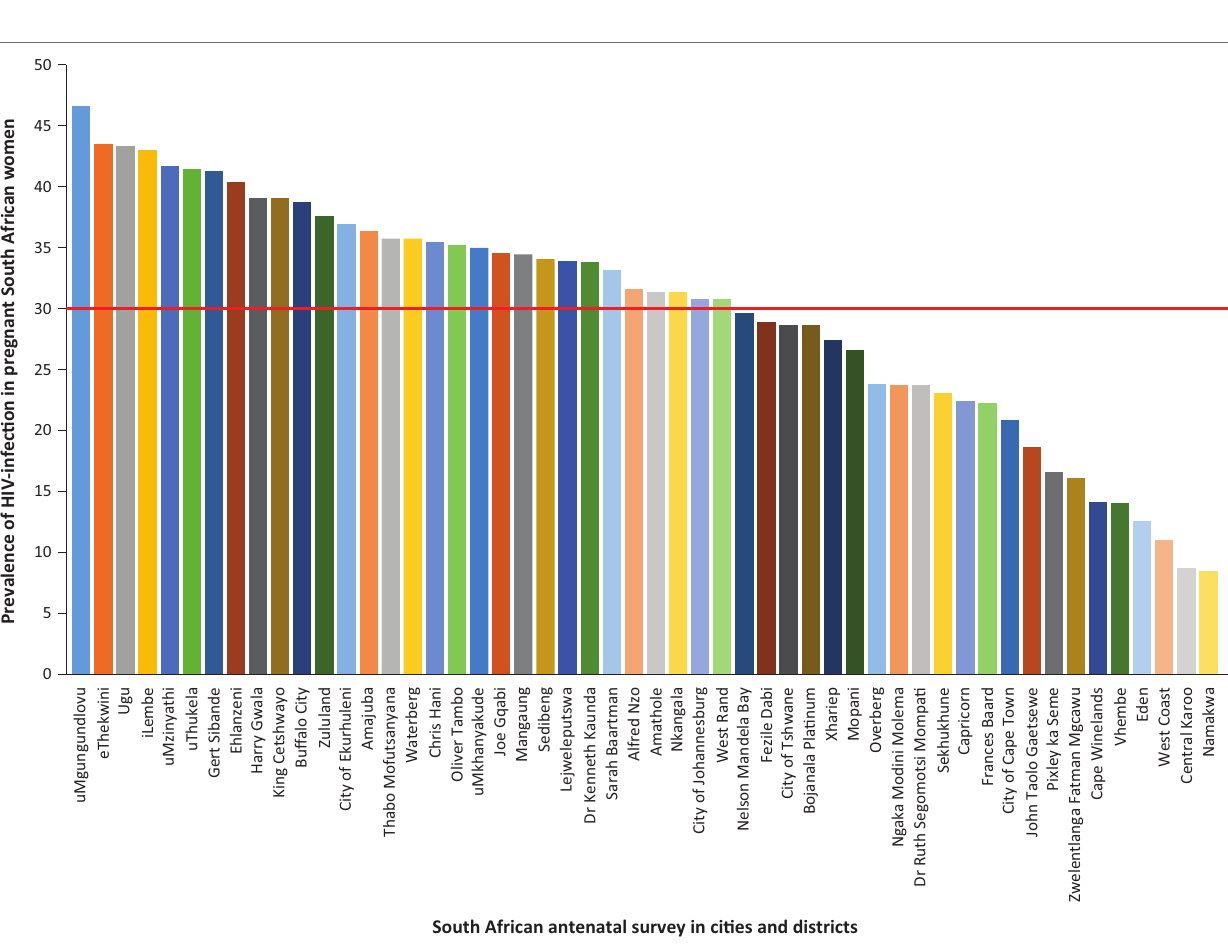
South African antenatal survey in ci(cid:13)es and